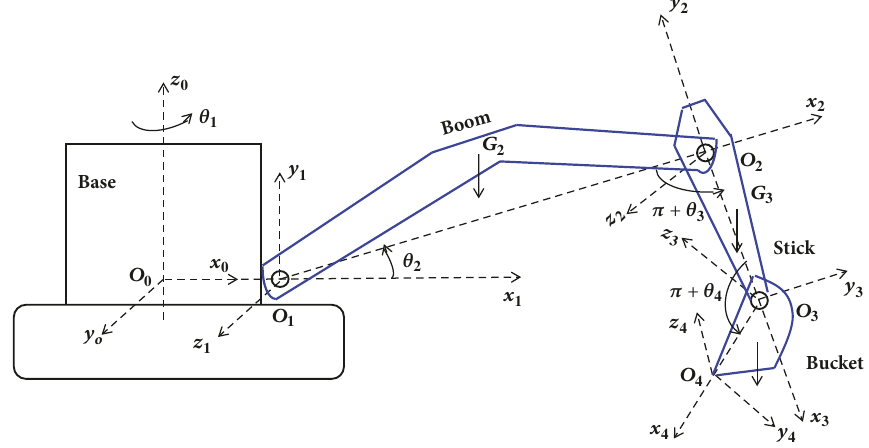
Figure 1: Block diagram of the excavator